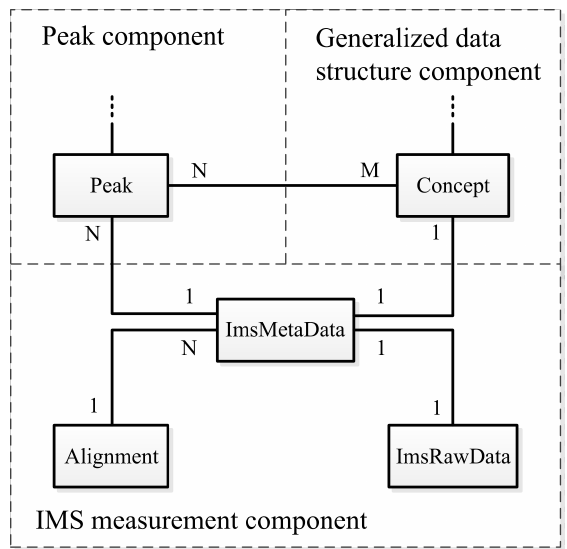
Figure 1: Overview of the three main database components and their relations. The central core entities of each component are linked directly. Auxiliary entities of generalized data structure and peak component can be found in the next paragraph. Associations and maximum cardinalities (one or many) are represented as solid lines labeled with characters 1, N,